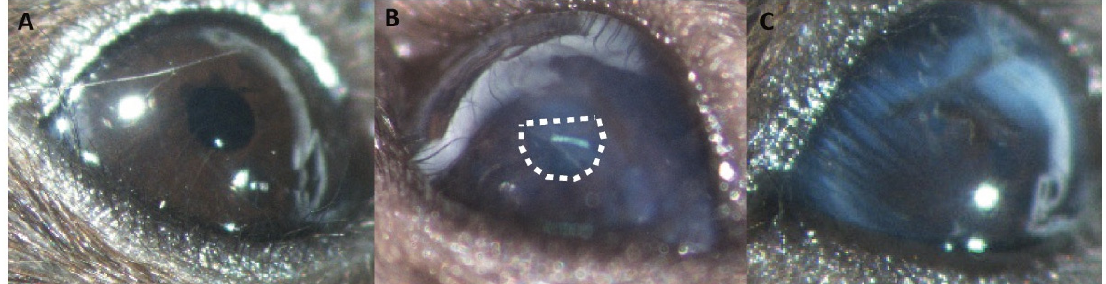
Figure 2. Tolerability of the EB270/HEA drug delivery substrate in the mouse eye. Eyes were examined 5 days following surgical removal of the native lens mass. In comparison with the unoperated eye (panel A ), eyes with the native lens replaced with the EB270/HEA substrate (panel B ) or following lens extraction alone (panel C ) showed no obvious signs of inflammation or irritation. The intraocular location of the substrate is outlined by a dashed line in panel ( B ).